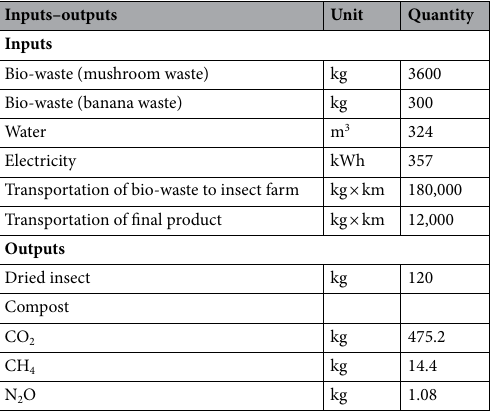
Table 6. Main primary inventory data for small-scale Protaetia brevitarsis seulensis